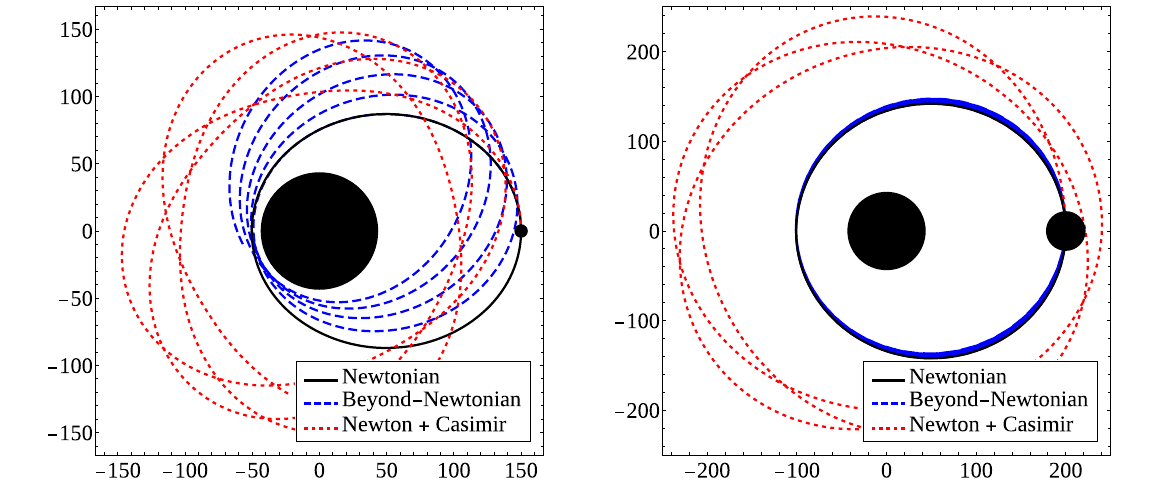
and R S = 5 μ m ( R S = 22 μ m) for the left (right) panel, respectively. The initial conditions used are the ones corresponding to Case 1 ( Case 2) as explained in the main text, and the Casimir force has been artifi- cially reduced by a factor of 10 − 3 (10 − 1 ). All distances are represented in